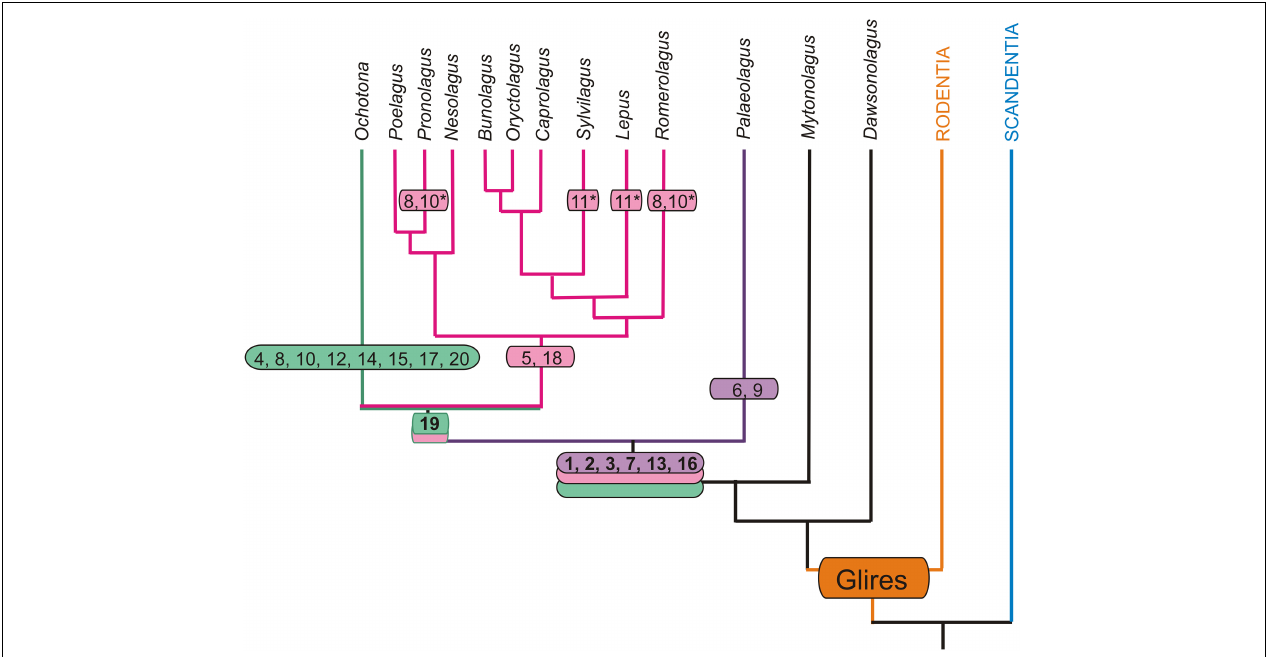
FIGURE 6 | Autapomorphic characters of the nasal and auditory regions in Palaeolagus haydeni and extant Lagomorpha mapped onto phylogeny of Matthee et al. (2004) and Fostowicz-Frelik and Meng (2013). Only those extant genera that have been previously investigated are considered (Ruf, 2014; Maier et al., 2018). Note that for Nesolagus data on the turbinal skeleton are not available. Apomorphic characters based on outgroup comparison (Rodentia + Scandentia): 1, dendritic maxilloturbinal; 2, excavated nasoturbinal contacts lamina semicircularis; 3, scrolled posterior margin of lamina semicircularis; 4, straight posterior margin of lamina semicircularis; 5, lamina semicircularis has a ventral lamina; 6, lamina semicircularis with anterolaterally projecting additional process; 7, interturbinal between frontoturbinal 1 and 2; 8, loss of interturbinal between frontoturbinal 1 and 2; 9, reduced frontoturbinal 2; 10, loss of ethmoturbinal III; 11, additional interturbinals; 12, bulla tympani strongly pneumatized; 13, contribution of ectotympanic to cranial floor (unclear in Ochotonidae); 14, caput mallei with distinct cristae; 15, loss of musculus tensor tympani; 16, anchoring of malleus via short processus anterior that ends in cavity formed by the ectotympanic and tegmen tympani; 17, anchoring of malleus via short processus anterior fused to bony trabeculae of pneumatized tegmen tympani (adult stages); 18, anchoring of malleus via extensive processus internus praearticularis fused to ectotympanic; 19, loss of secondary crus commune; 20, high cylindric cochlea; asterisk (*) denotes characters restricted to certain